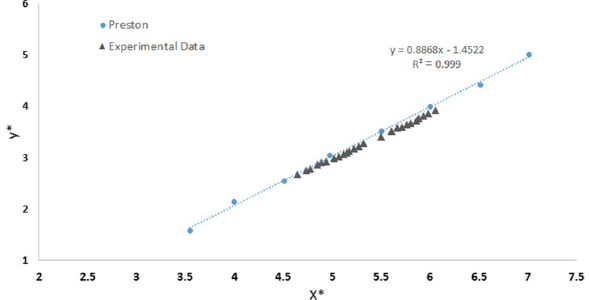
Fig. 2 Non-dimensional shear stress parameters y ∗ versus differential pressure x ∗